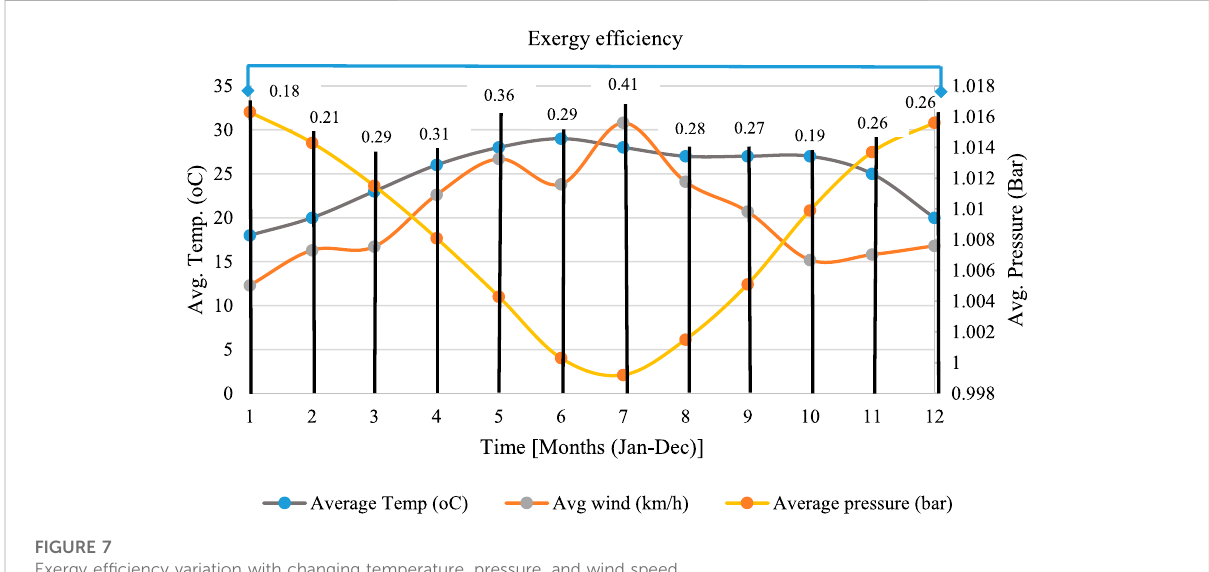
FIGURE 7 Exergy ef fi ciency variation with changing temperature, pressure, and wind